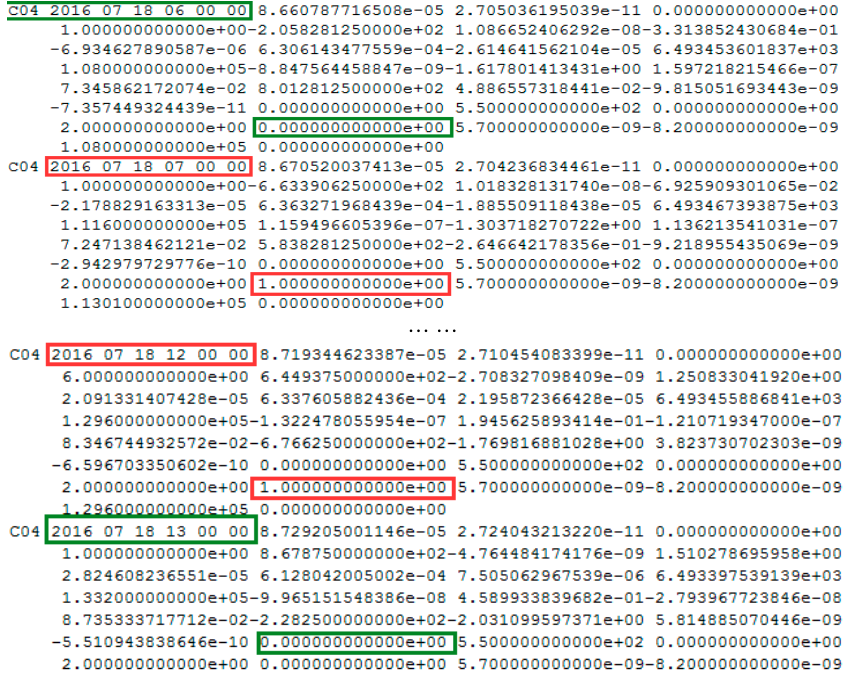
Figure 5. The health status of C04 in the broadcast ephemeris. The red box highlights the unhealthy status marked as 1. The blue box highlights the healthy status marked as 0. Note that the data is not displayed from between 8:00 and 11:00 to limit the size of the figure and the health status are all marked as 1 during this period.